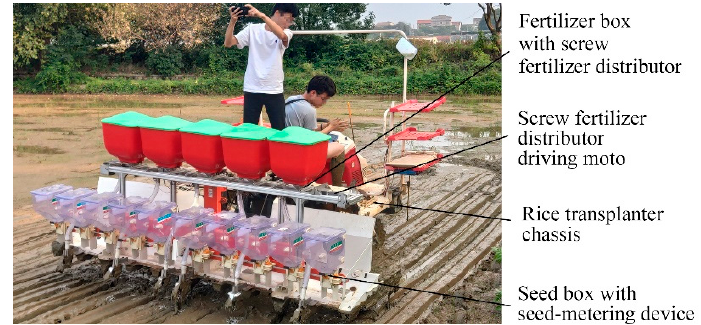
Figure 6. Screw fertilizer distributors with DAIDO DXZ830 rice seeding machine. The fertilizer used in field test was Guihu compound fertilizer (N-P 2 O 5 -K 2 O content was 15%-15%-15%, bulk density was 1.11 g/cm 3 , and moisture content was about 3.71%). The paddy field was divided into six experiment plots, each plot had a length of 40 m and a width of 2.55 m. The field test was repeated three times, each test fertilized in two plots. After the test, the CVFS, variation coefficient of the fertilization consistency in different rows (CVODR), and the relative error of fertilization amount were measured.